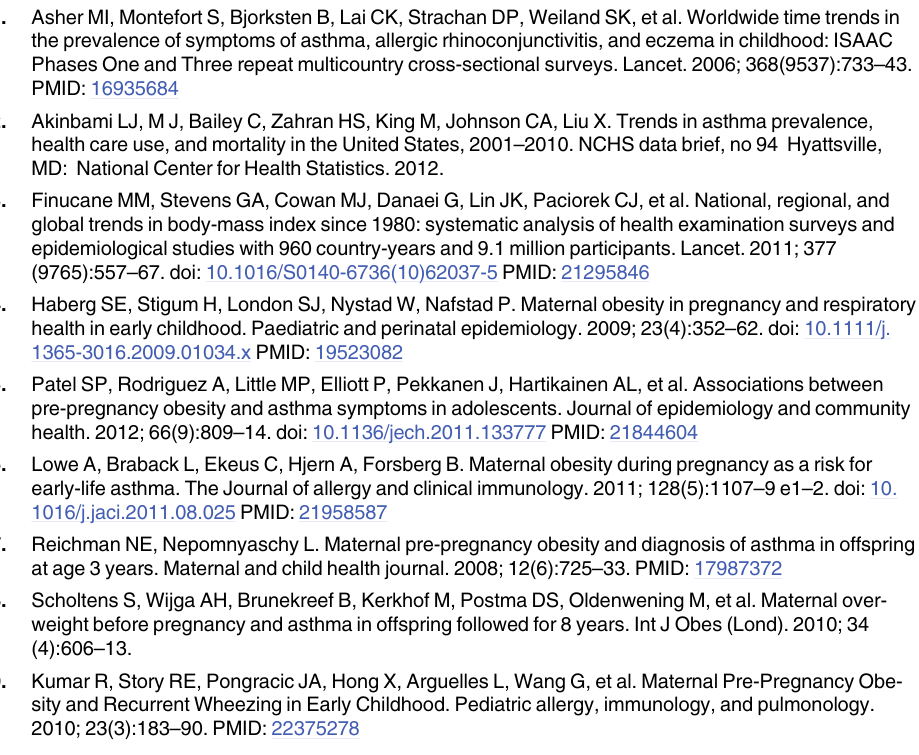
S1 Table. Demographic differences (mean or prevalence), between mother-child pairs with follow up at 7 years or multiple imputed data for mother-child pairs with follow up at either 3 months or 7 years. S2 Table. Risk Ratio ’ s of respiratory outcomes in offspring in relation to prepregnancy BMI from imputed dataset (n = 5579). † Risk ratios estimated by logistic regression; ¥ Risk ratios estimated by Poisson Regression; ‡ adjusted for length of education (categorical), mater- nal age, western ethnicity, and parental asthma; ^ adjusted for: duration of breastfeeding; length of education (categorical); maternal age; western ethnicity; parental asthma; parity; mode of delivery; smoking during pregnancy; and domestic